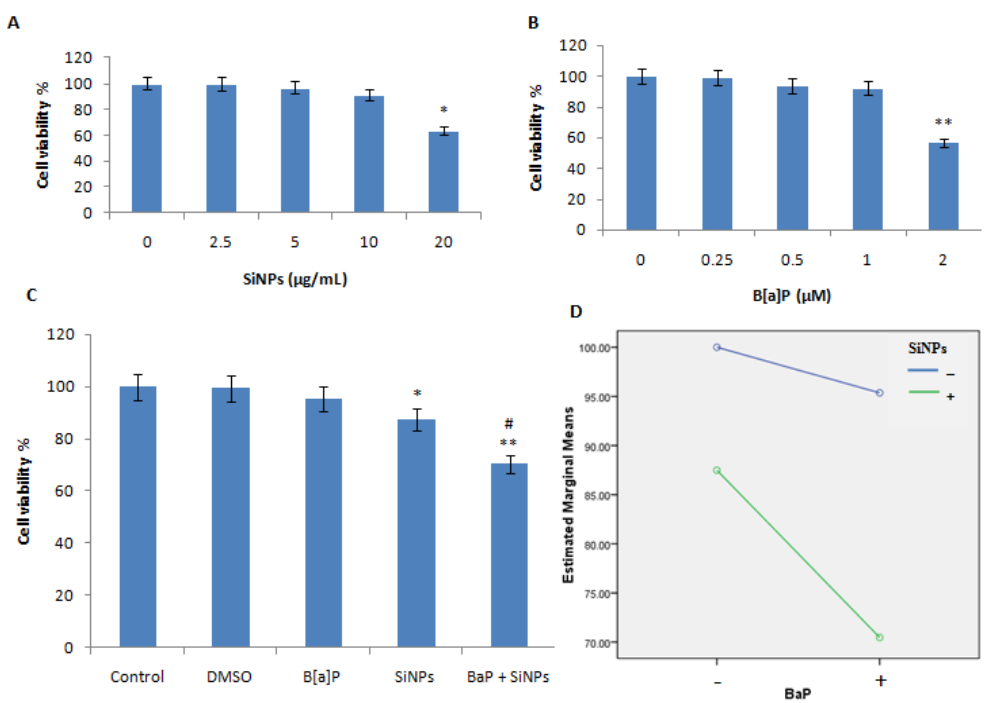
Figure 2. Effects of SiNPs and/or B[a]P on HUVECs’ viability. ( A ) Cell viability of various concentrations of SiNPs; ( B ) Cell viability of various concentrations of B[a]P; ( C ) Cell viability of HUVECs treated with DMSO (1%), SiNPs (10 μg/mL), B[a]P (1 μM), and their mixture (10 μg/mL + 1 μM); ( D ) Profile